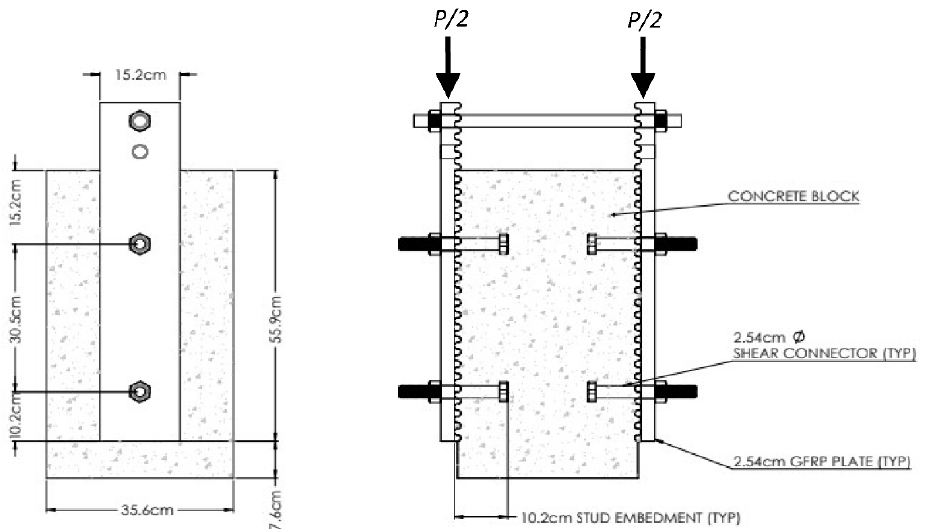
Figure 5. Shear Block Test Specimen Details and Geometry.